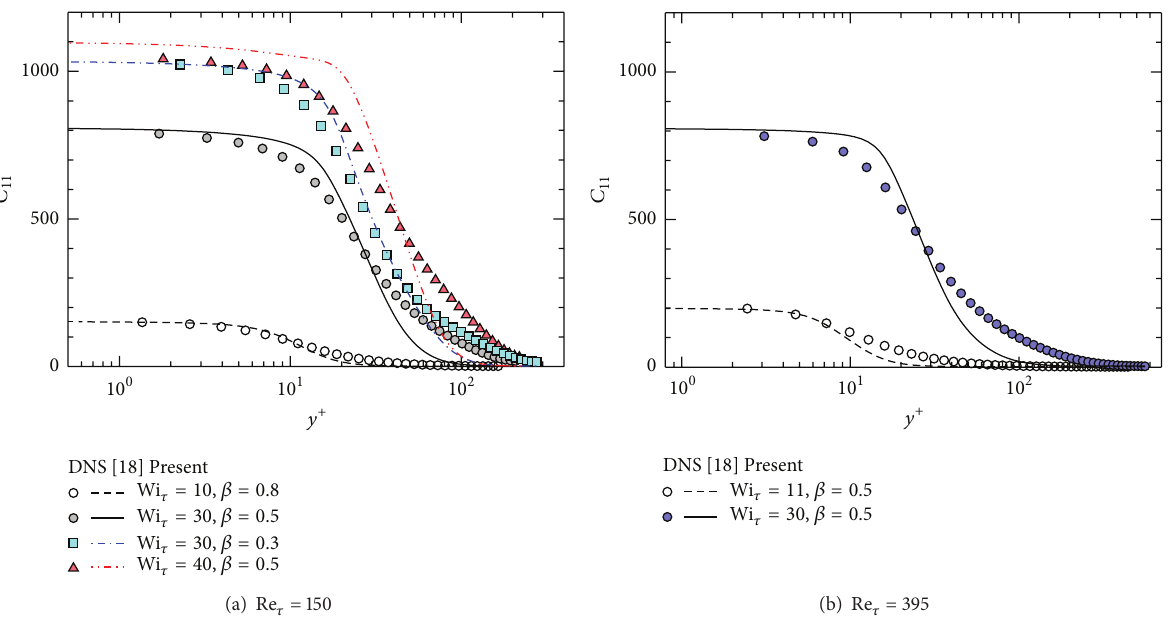
Figure 10: Same with Figure 6, but with respect to a conformation normal stress, 𝐶 + 11 .